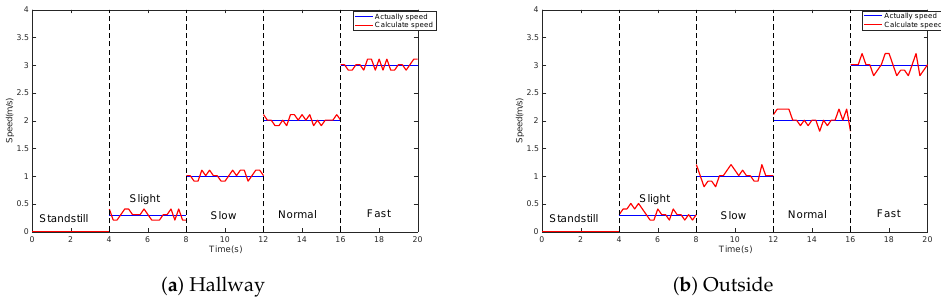
Figure 8. Comparisons of the measured speed and the actual speed.